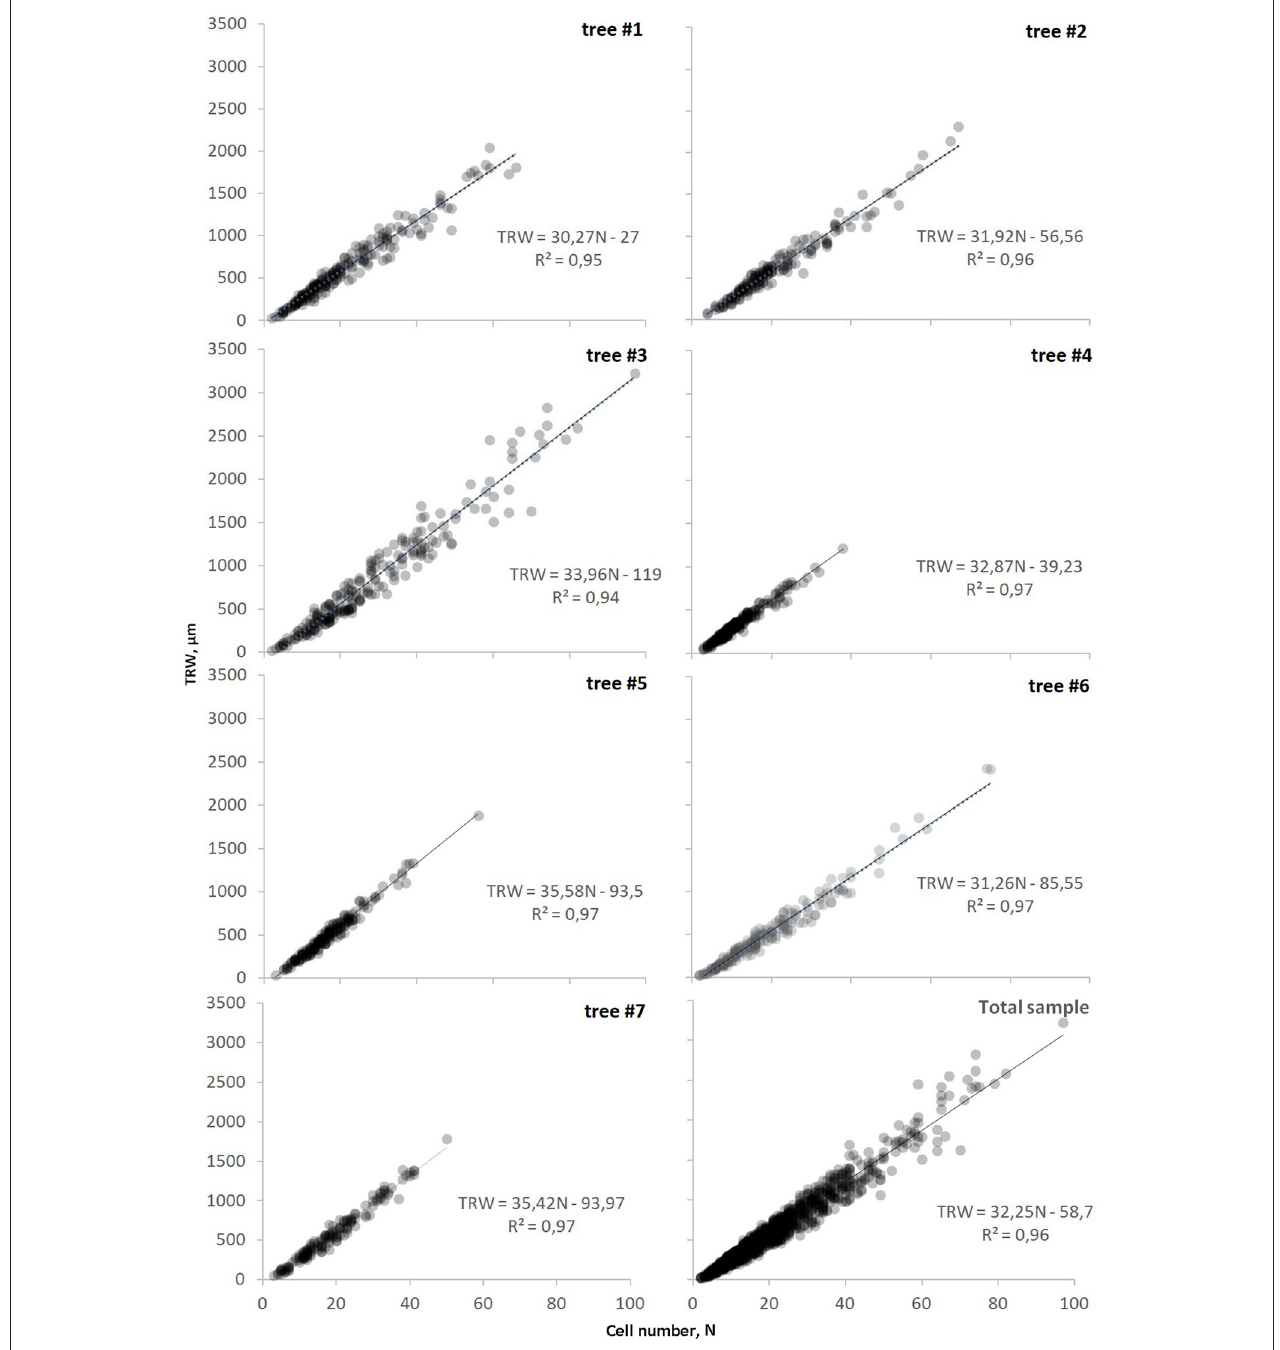
FIGURE 3 | Dependencies of tree-ring width on cell number, TRW ( N ), for each investigated tree and on the scale of sampling site (total sample). Markers (circles) represent actual tree rings and line represents the linear function of relationship (equation and coefficient of determination R 2 is shown on each plot).